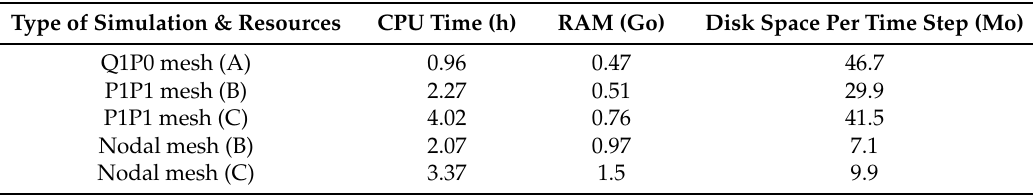
Table 3. Computing times and hardware resources for pass